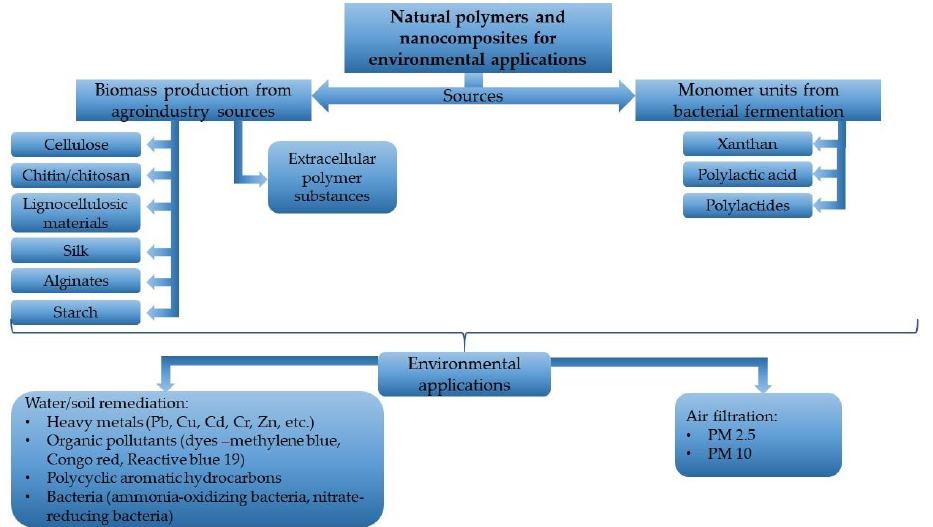
Figure 1. Natural polymers and nanocomposites for environmental applications.